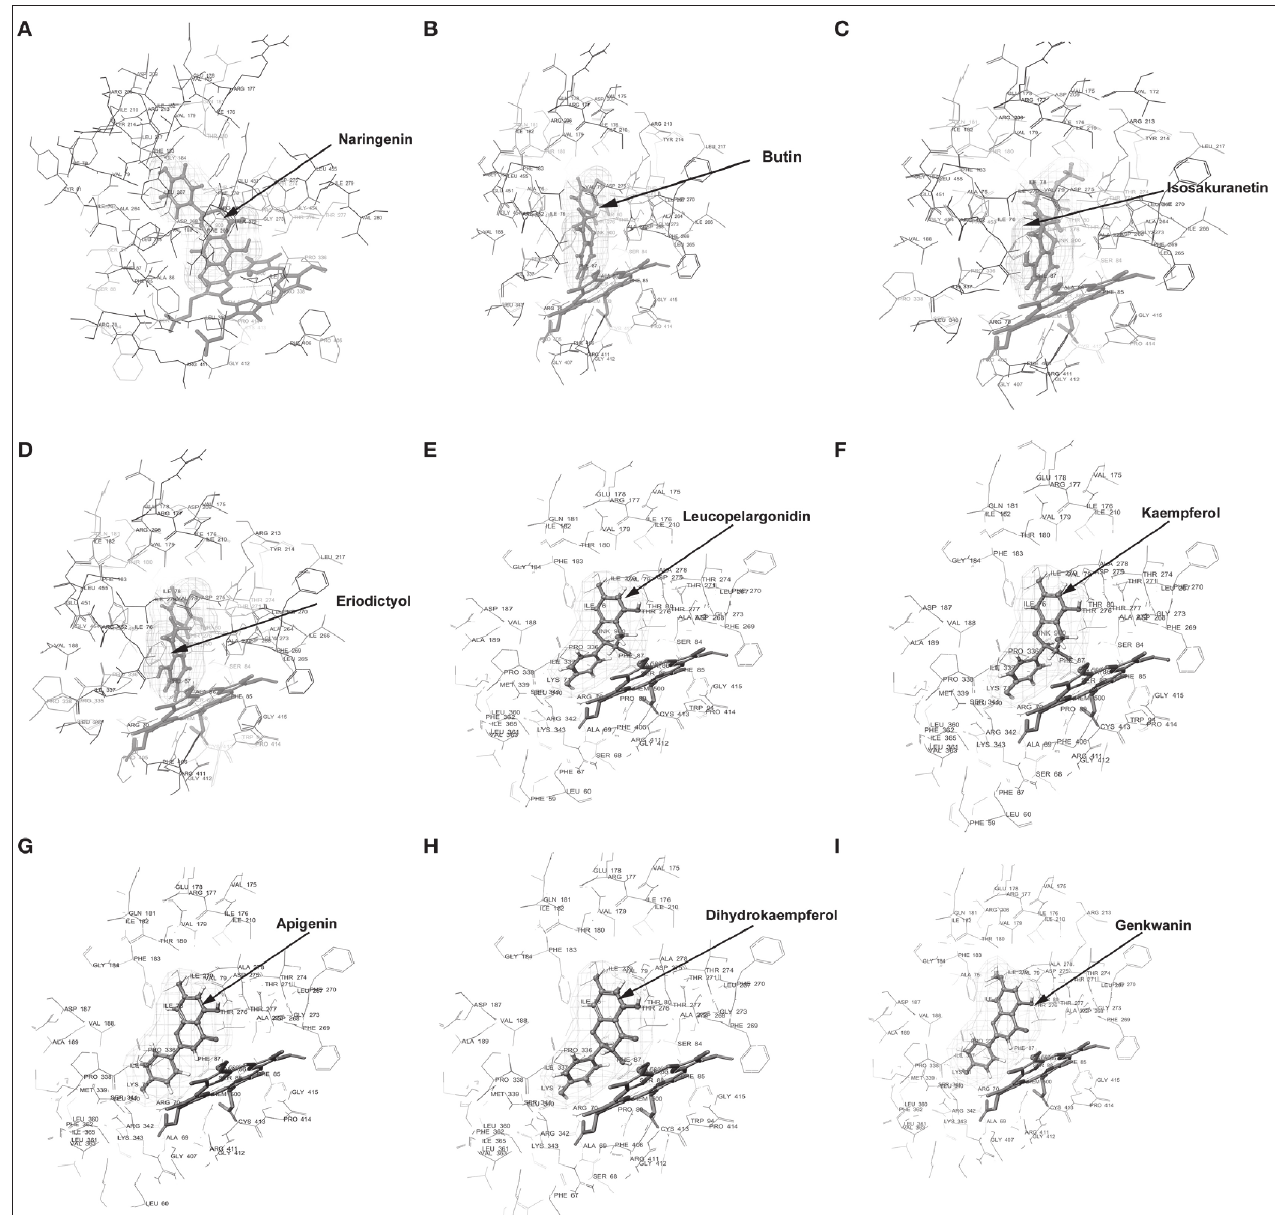
FIGURE 4 | Molecular docking of CfCYP93B. Diagram showing (A) Naringenin, (B) Butin, (C) Isosakuranetin, (D) Eriodictyol, (E) Leucopelargonidin, (F) Kaempferol, (G) Apigenin, (H) Dihydrokaempferol, (I) Genkwanin, docked in the proposed binding pocket (above heme plane) of CfCYP93B. Mesh represents the ligand